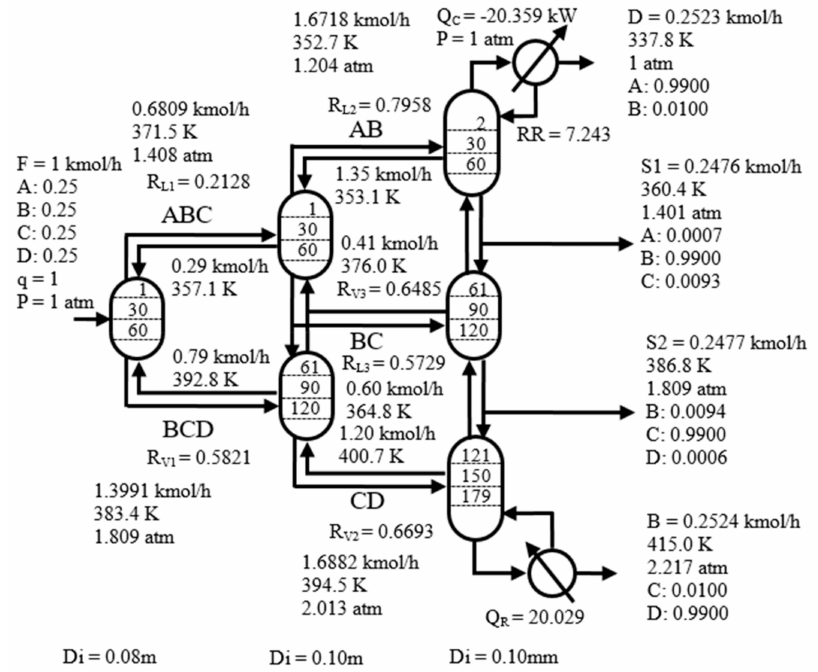
Figure 3. The detailed data of the four-product extended Petlyuk